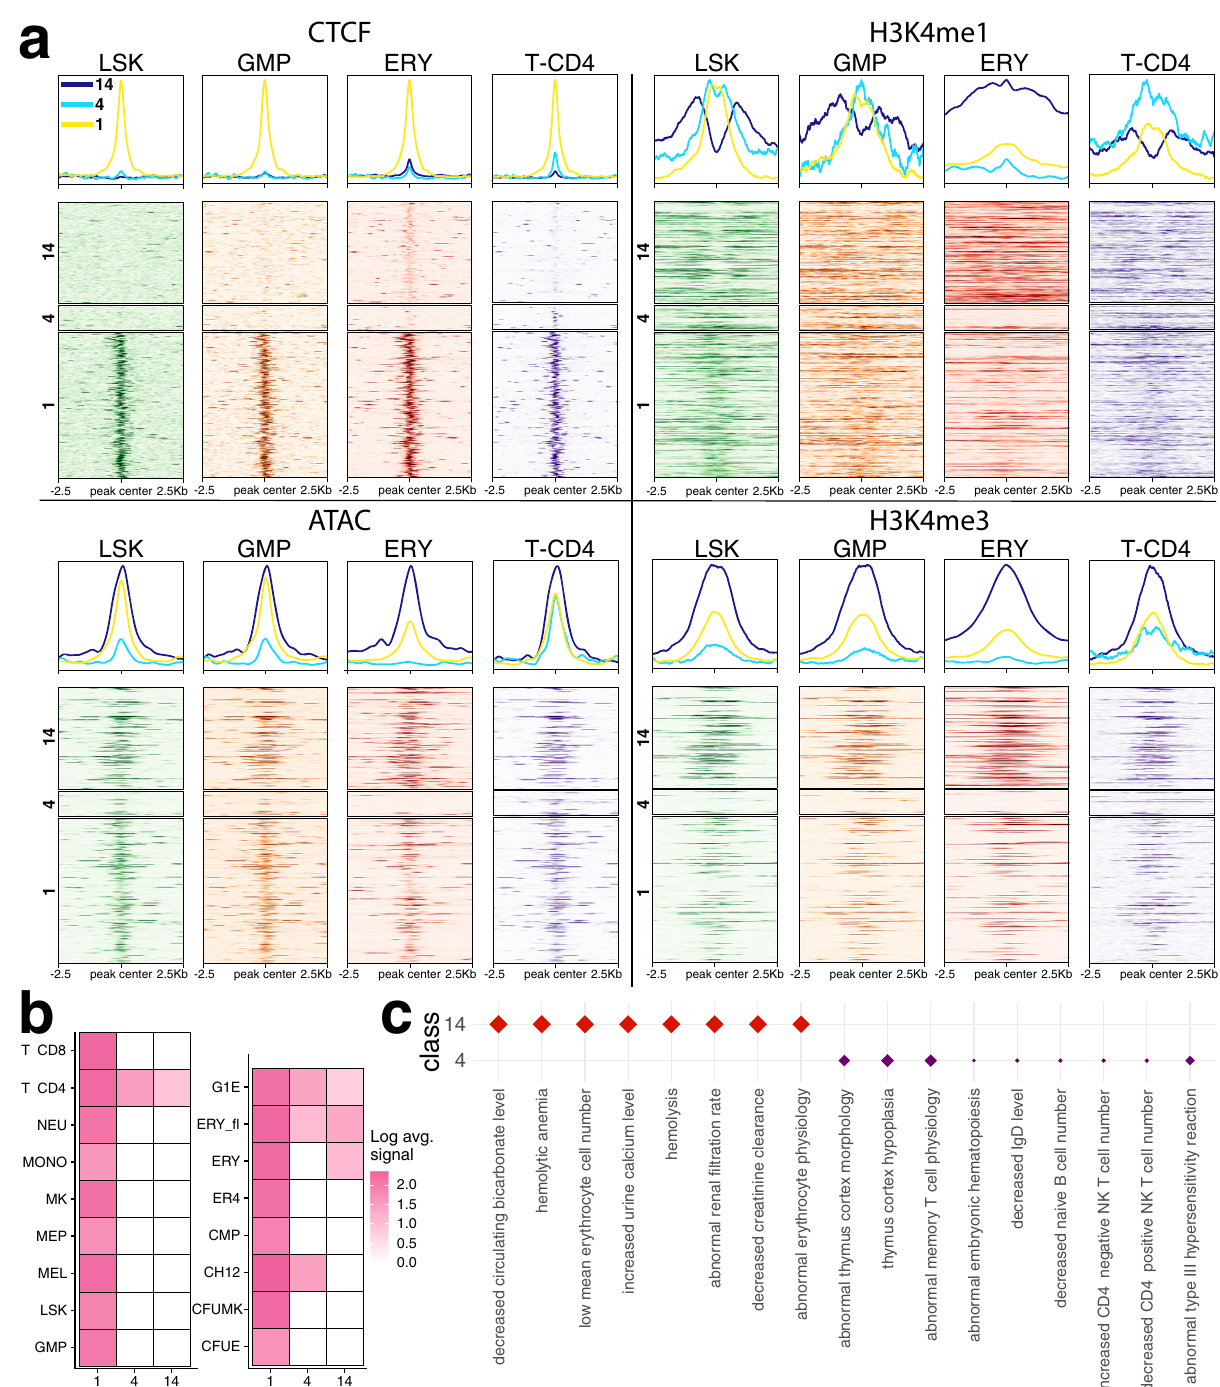
Fig. 3 | CTCF binding patterns uncovered by CLIMB capture different patterns ofepigeneticmodi fi cations.a Datafromthelocionchromosome11thatbelongto classes of CTCF binding patterns (numbered 1, 4, and 14) identi fi ed by CLIMB are shown. The original CTCF ChIP-seq, alongside ATAC-seq and histone modi fi cation ChIP-seq data in 4 hematopoietic cell populations reveal differing patterns of epi- geneticmodi fi cationsacross cellpopulations. b Logclass meansbased onCLIMB ’ s